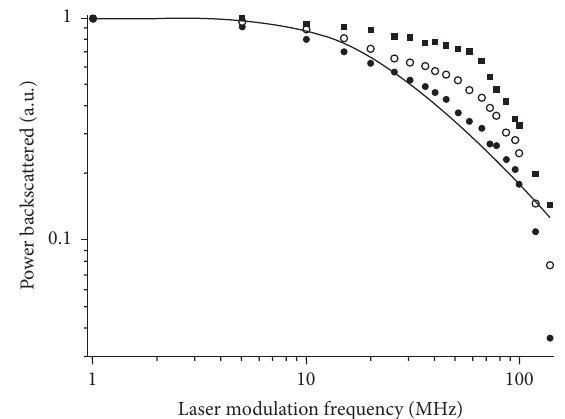
Figure 1: Normalized backscattered power vs. laser modulation frequency measured for different water attenuation coefficients: ( ● ) k � 0.5m − 1 , ( ○ ) k � 1.1 m − 1 , and ( ■ ) k � 2.1m − 1 . The continuous curve is the plot of Butterworth’s filter function in equation (2) for k � 0.5m − 1